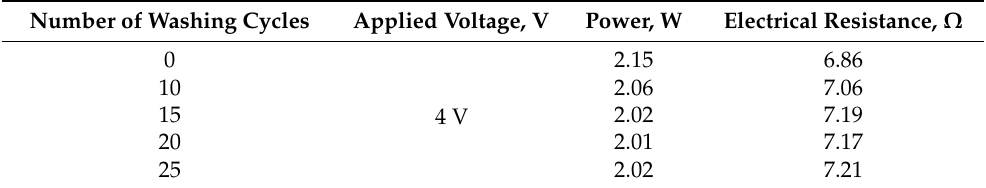
Table 7. Electrical properties of the heating insert (variant B) after multiple washings.